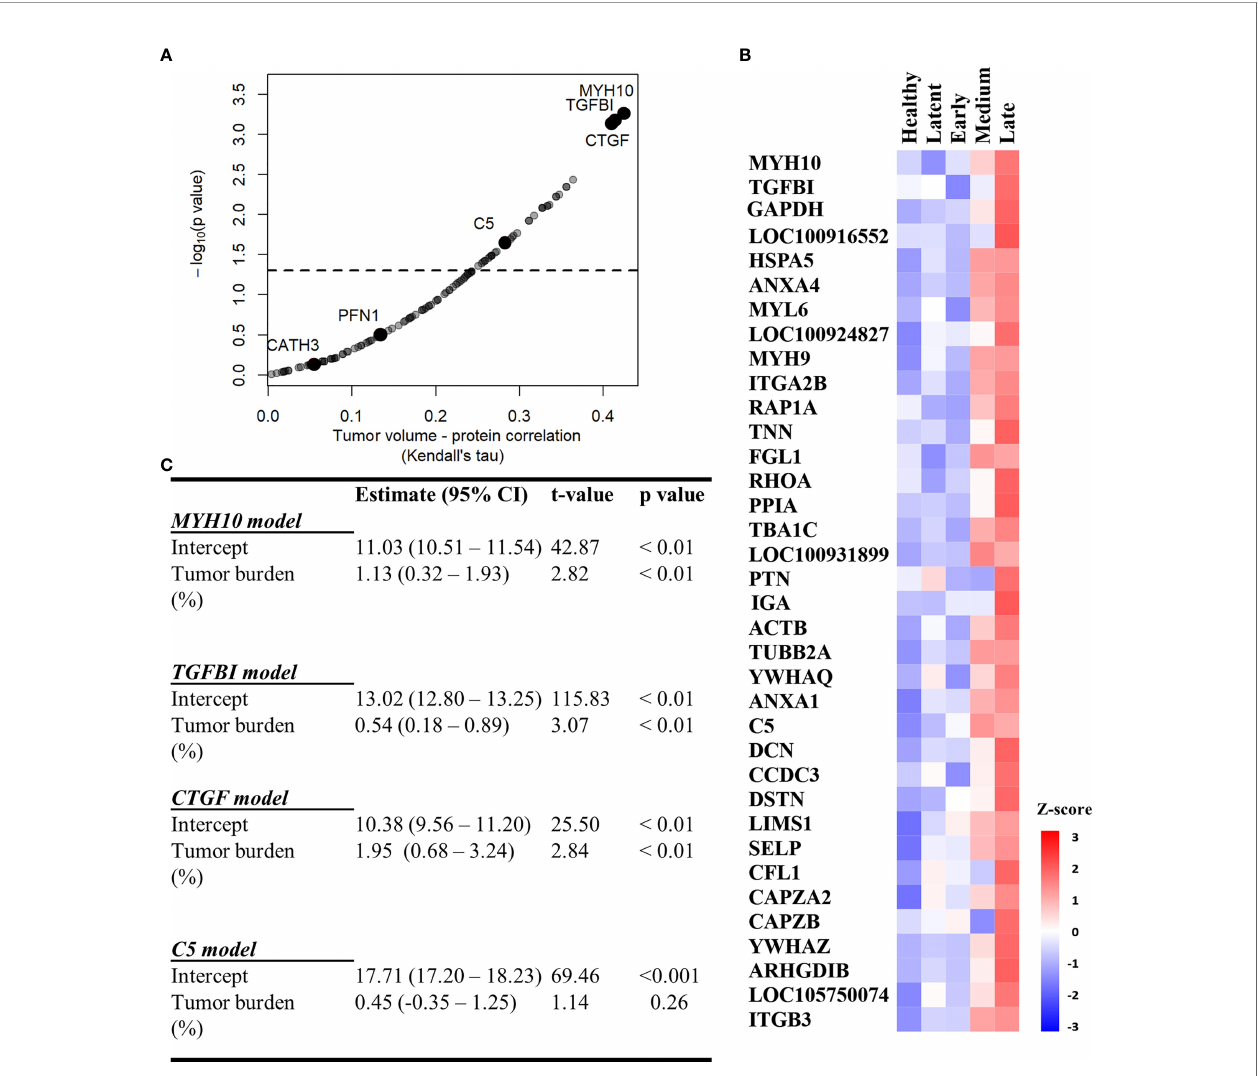
FIGURE 5 | MYH10, TGFBI, and CTGF are associated with tumor burden. (A) Kendall Correlation of proteins with tumor volumes (DFTD infected animals from the discovery and validation dataset, n=45). Proteins with a corrected p value < 0.05 are plotted above the dashed and black line. (B) Heat map representing EV sample proteins with signi fi cant Kendall correlations. Z-scored abundances were calculated from the mean of the relative abundance of each protein in each category (27 healthy (wild and captive), 15 latent, 17 early, 15 medium, and 13 late-DFTD devils). (C) Linear regression models of % tumor burden as a predictor of MYH10, TGFBI, CTGF and C5 relative